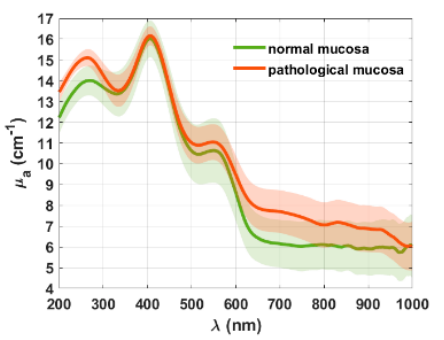
Figure 7. Mean µ a ( λ ) of the normal and pathological mucosa.